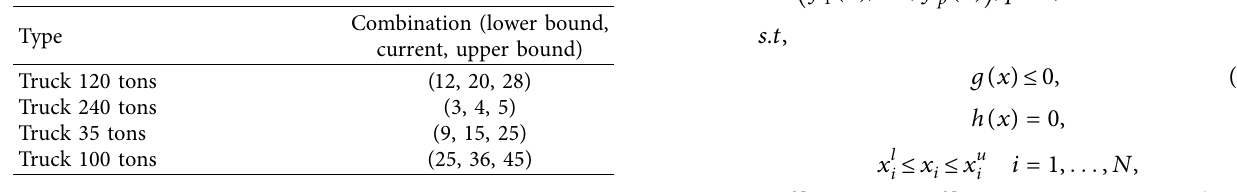
Table 3: Number of trucks combination at each type.